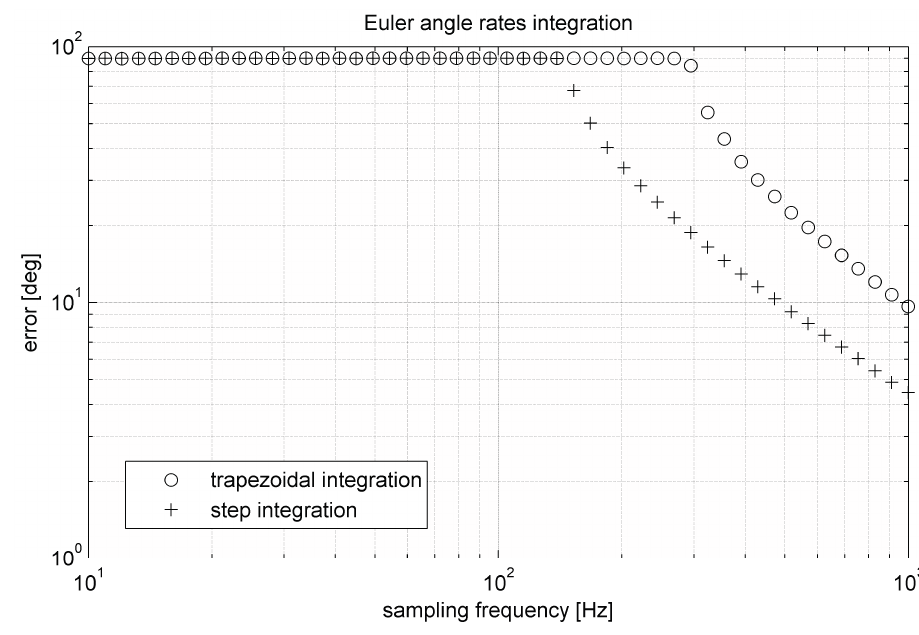
Figure 9. Relation between error and sampling frequency in the algorithm based on the integration of the Euler angle